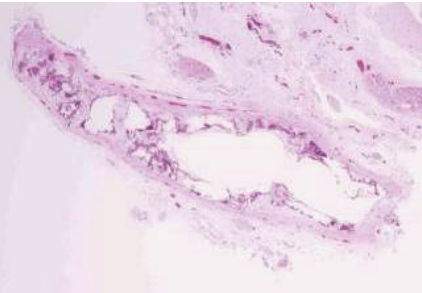
of NPP1 activity will lead to less PPi generation. Bispho-